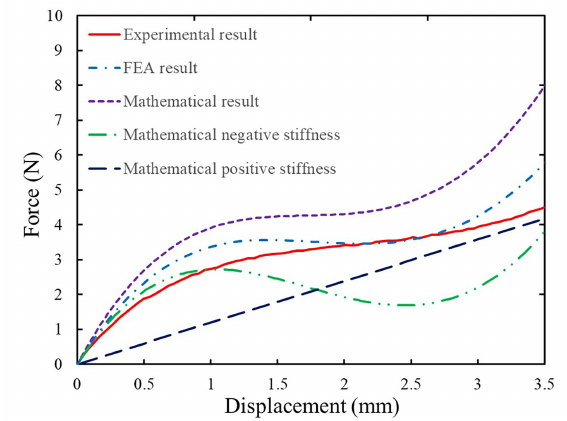
Figure 2. Comparison of FEA results, mathematical results and experimental results of the prelimi- nary constant force